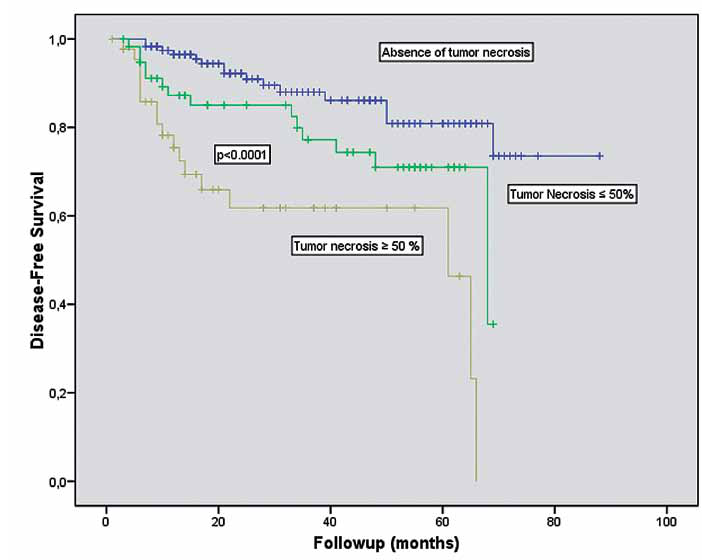
Figure 2 - 118 patients without tumor necrosis had higher 5-year survival than 61 with percentage of tumor necrosis less than 50% and 47 with percentage of tumor necrosis greater than 50%. (Kaplan-Meier log rank test p <